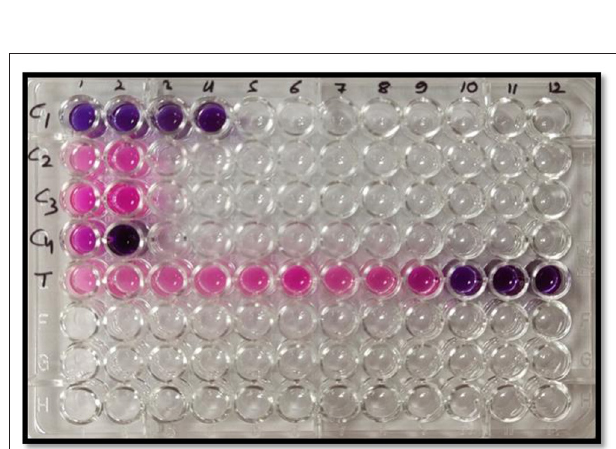
FIGURE 7 | Representative plate of the resazurin assay (pink color indicates growth and blue color indicates no growth); C 1 : sterile control (broth + indicator); C 2 : negative control (broth + indicator + fungus); C 3 : negative control (broth + indicator + fungus + surfactant solution); C 4 : positive control (broth + indicator + fungus + Nativo in two concentrations); T (broth + indicator + fungus + test emulsion in serial dilution with increasing concentration in wells